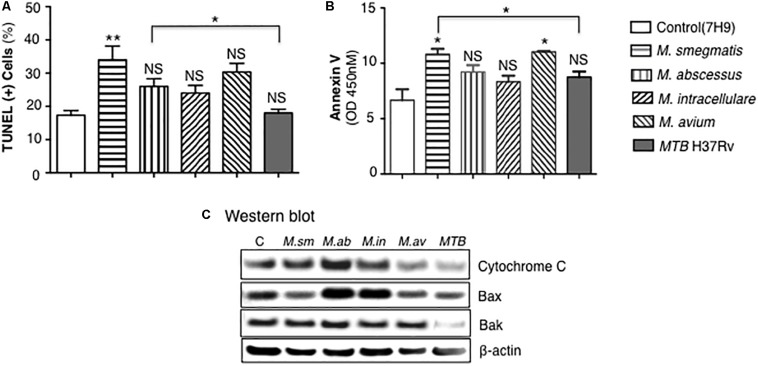
MTB H37Rv induced less apoptosis than other mycobacterial species. (A) Quantitation of THP-1 cell apoptosis by TUNEL staining 24 h after infection with the individual mycobacterial species. (B) Annexin-V expression was quantified in THP-1 macrophages infected overnight with various mycobacterial species. Data shown are the mean ± SEM of three independent experiments. (C) Cytochrome C, Bax, and Bak expression was determined by immunoblotting of the lysates of THP-1 cells infected with various NTM species and MTB H37Rv. Immunoblots shown are representative of three independent experiments. Unless otherwise indicated, *p < 0.05, **p < 0.01 are compared to unstimulated control cells (open bars). Multiplicity-of-infection of 10 mycobacteria:1 macrophage.